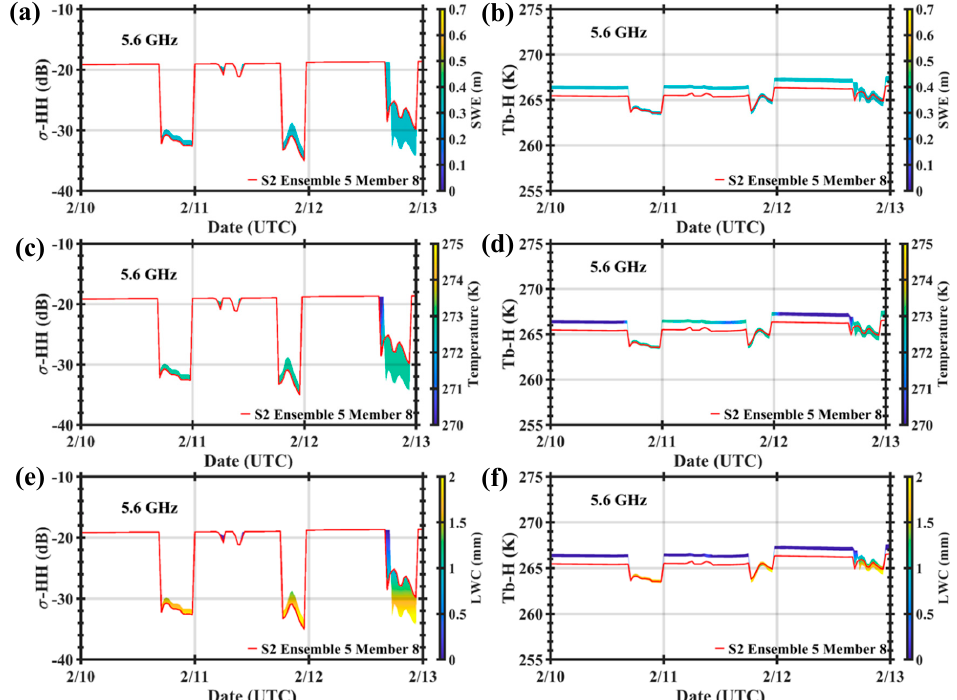
Figure 13. Diurnal cycle of 5.6 GHz σ -HH and H-pol brightness temperatures contoured by SWE (a , b ), and temperature ( c , d ) and liquid water content (LWC, e , f ) of the top layer of the snowpack at S2 over the period 2/10–2/13 for EFF2. The ~10 dB range on 2/12 results from compounding nonlinear effects of modest sub-grid-scale spatial variability of snow depth (Figure S12) and mid-day temperatures above the freezing level that cause melting at the snowpack surface. UTC = Mountain Standard Time + 7.